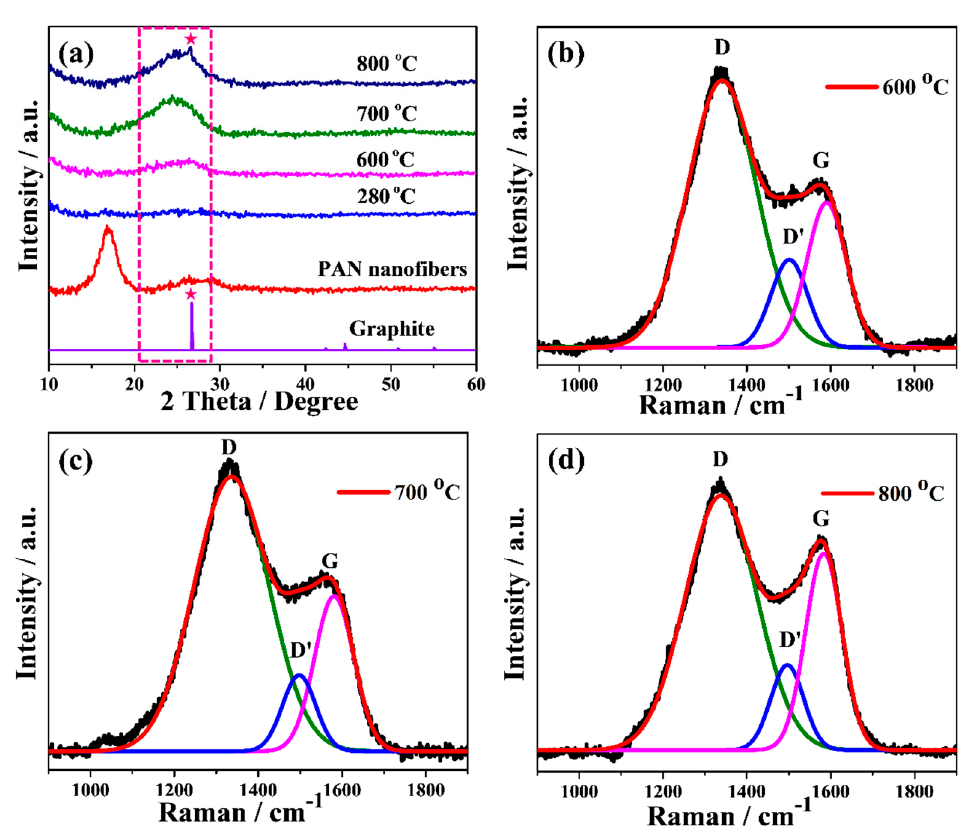
Figure 3. ( a ) XRD patterns and ( b – d ) Raman spectrum with the corresponding curve fitted bands of stabilized and carbonized PAN12 precursor nanofibers at different temperatures.